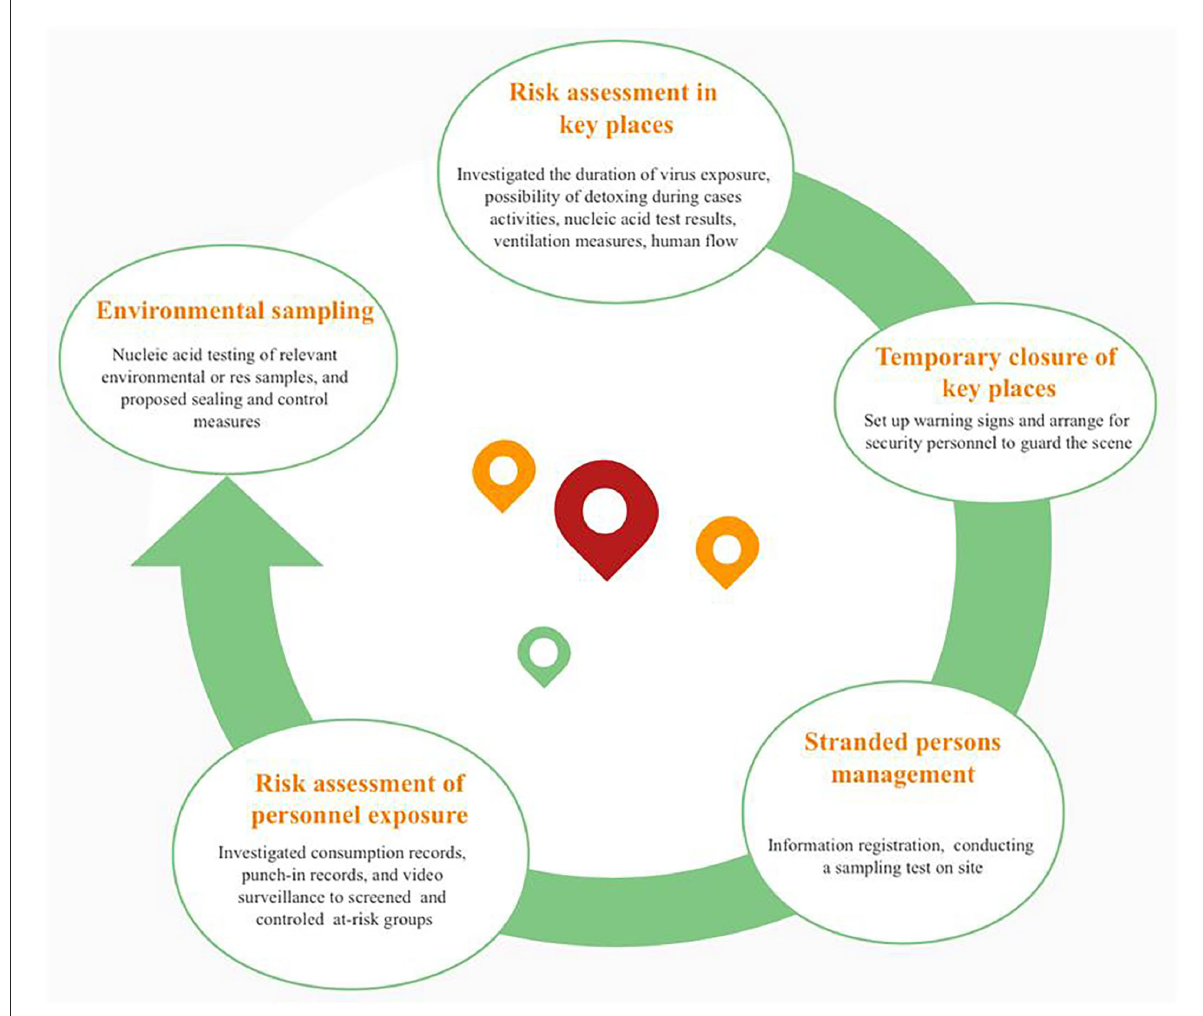
FIGURE2 Identification and management of key